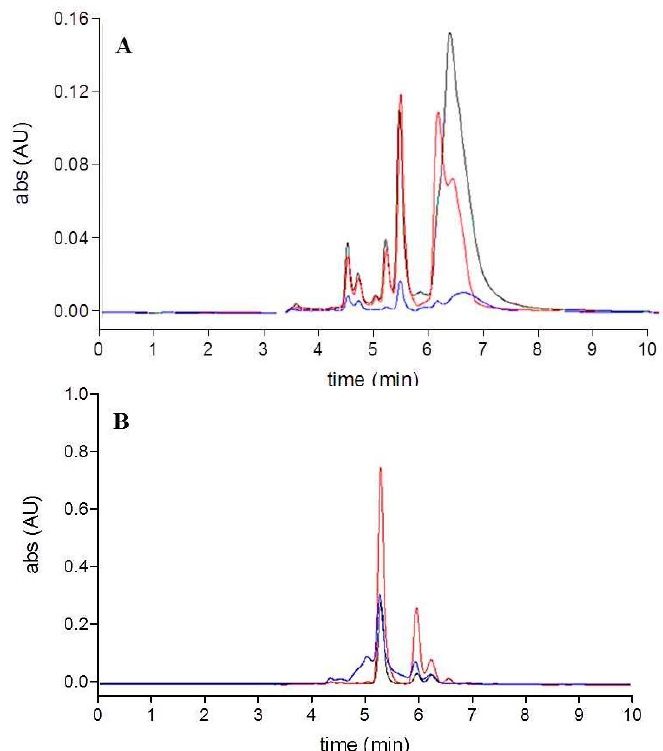
Figure 4. HPLC chromatograms (449 nm) obtained after light exposure of the extracts: ( A ) conventional extracts (acetone-black, acetonitrile-red, methanol-blue); ( B ) extracts obtained using QuEChERS method (acetonitrile raw extract-blue, PSA cleanup-red, GCB additional